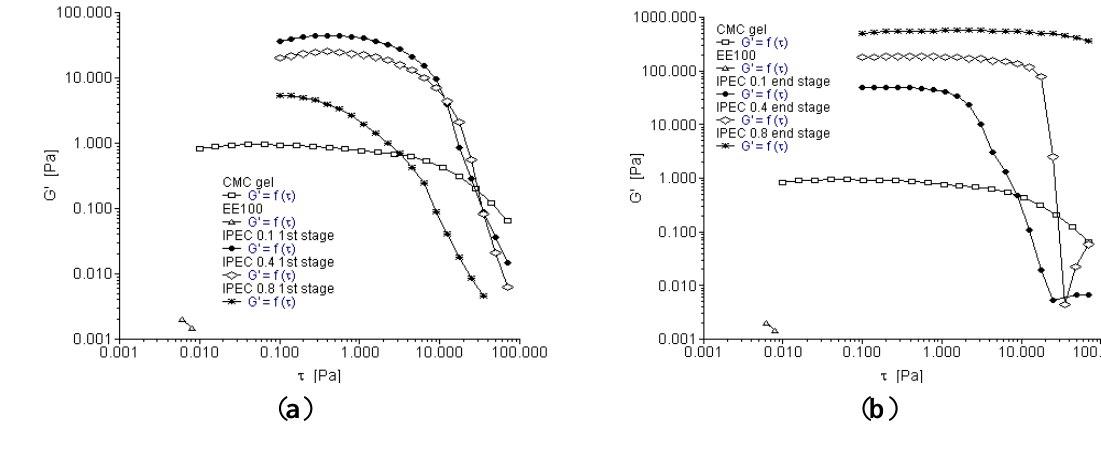
Figure 3. Elastic modulus as a function of shear stress for ( a ) the native polymers and IPEC at 1st stage of synthesis at frequency of 0.1 Hz; ( b ) the native polymers and IPEC at end stage of synthesis at frequency of 0.1 Hz; and ( c ) IPEC 0.1 N at the 4 sampling points of synthesis at frequency of 0.1